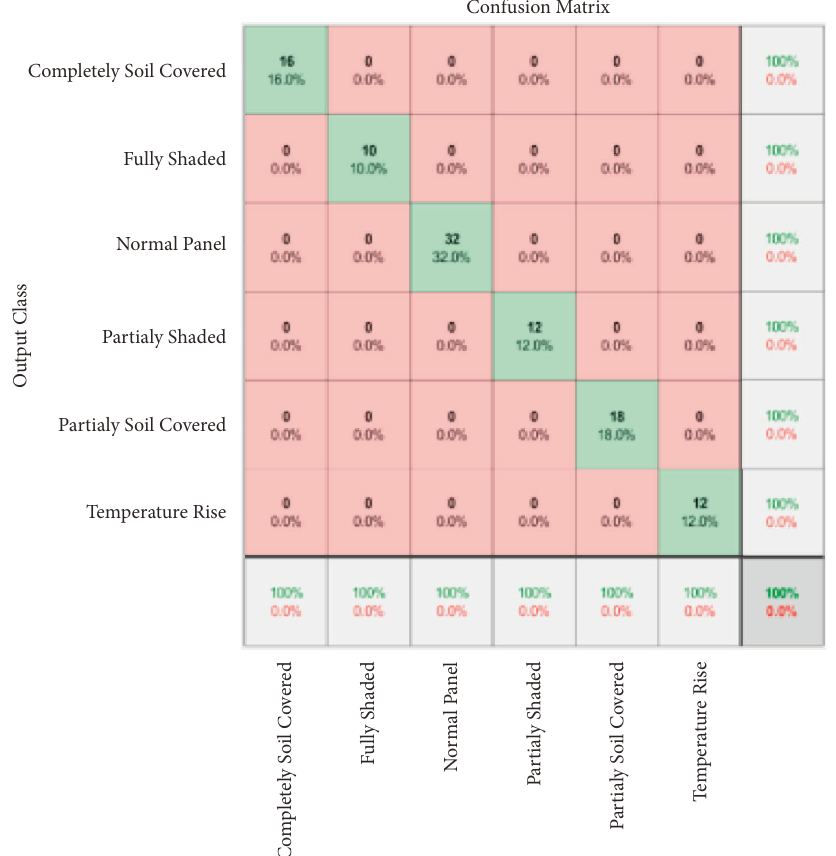
Figure 22: Confusion matrix for real images with fault in solar panels.